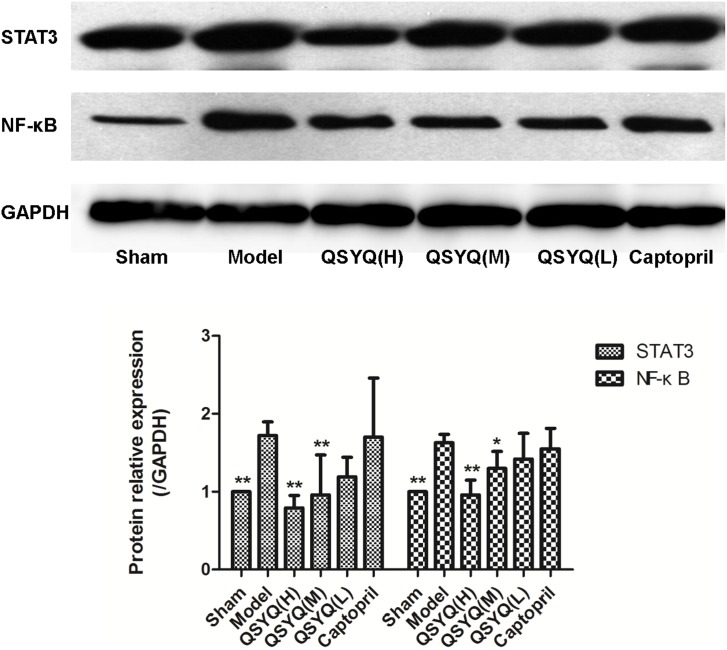
QSYQ significantly decreased cell signal transduction pathway factors of STAT3 and NF-κB in rats with HF.NF-κB in model group increased compared with sham, while treated by QSYQ (H) and (M) doses, the NF-κB level was significantly decreased. TheSTAT3 level in model group was up-regulated, while QSYQ at doses of 9.33 mg/kg (H) and 4.67 mg/kg (M) significantly decreased the STAT3 level respectively. After the administration of QSYQ (L) and captopril, the level of NF-κB and STAT3 had no statistical significance compared to model group. n = 10∼14 for each group. Data were analyzed by one-way ANOVA, with p<0.05 indicating statistical significance. *Differed significantly from the model group (p<0.05).